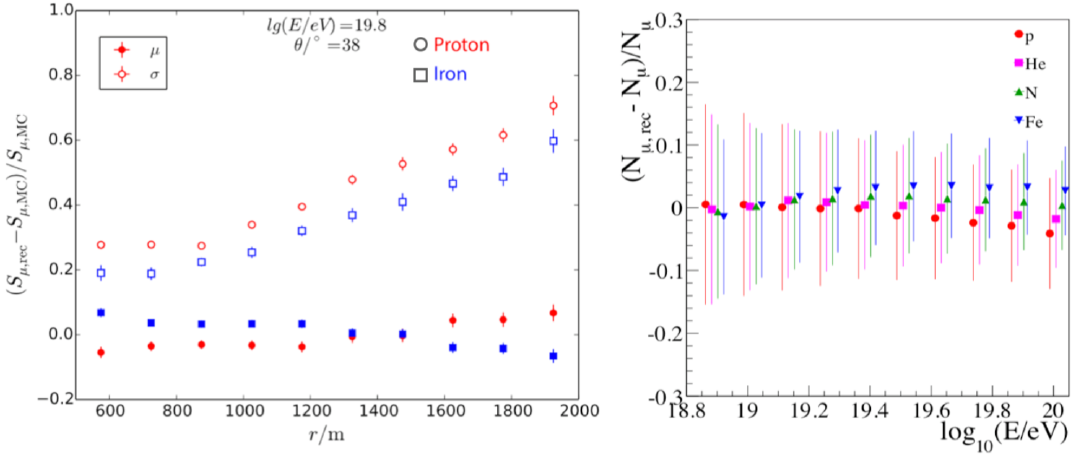
Figure 6. Left: Reconstruction bias (full symbols) and resolution (empty ones) for the muonic signal derived with the matrix inversion method in individual stations, as a function of distance to the shower core, for protons (circles) and iron nuclei (squares). Right: Relative di ff erence between the number of muons reconstructed in individual showers using shower universality and the true (Monte Carlo) ones as a function of energy for di ff erent primary species. Error bars represent the RMS of the